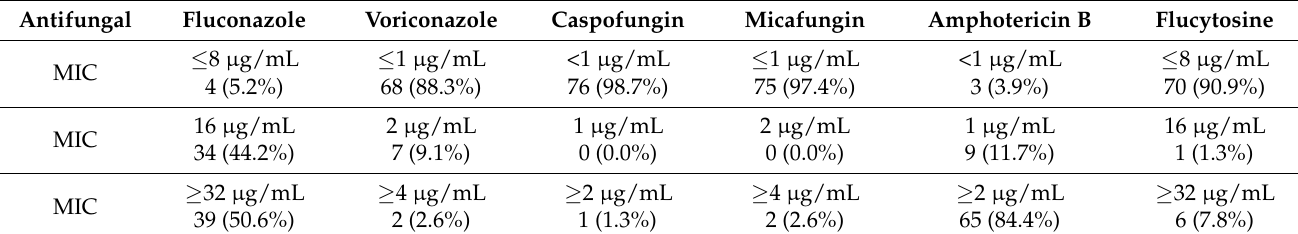
Table 2. C. auris isolate (N = 77) distributions among different MIC values for the antifungal agents tested. Antifungal